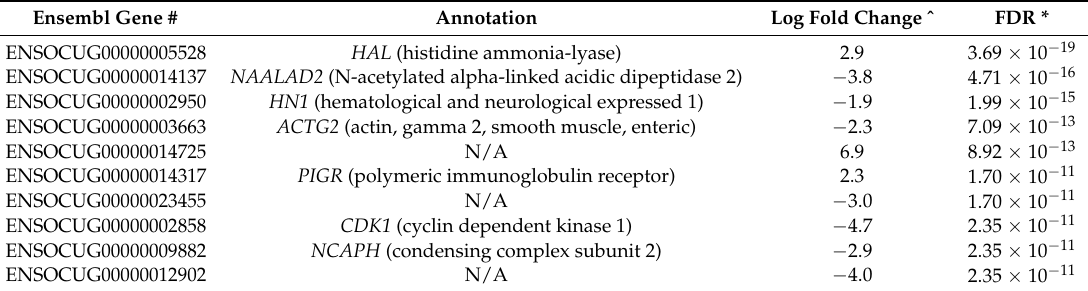
Table 3. The top 10 most differentially expressed genes between control adults and control